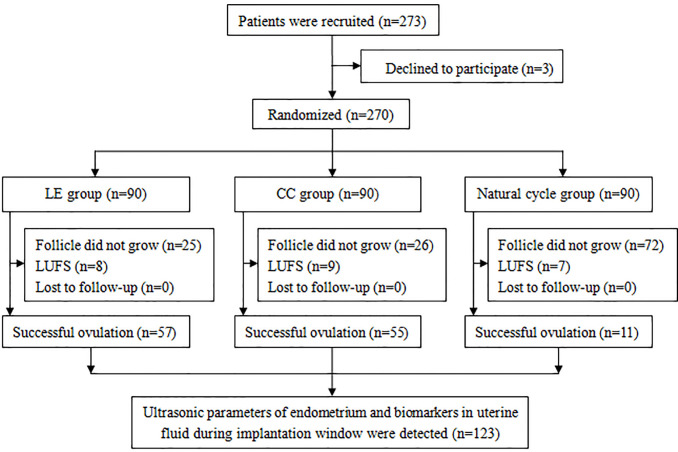
Flow chart of the study. (LUFS, luteinized unruptured follicle syndrome).